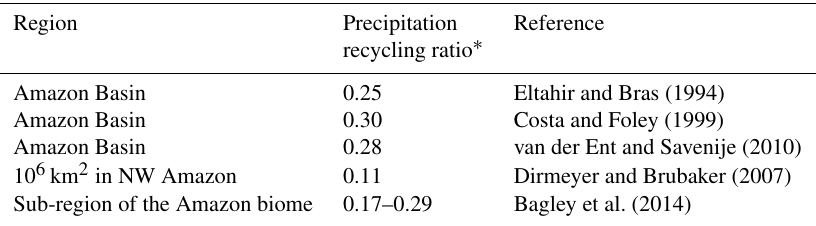
Table 3. Annual precipitation recycling ratios for the Amazon region.